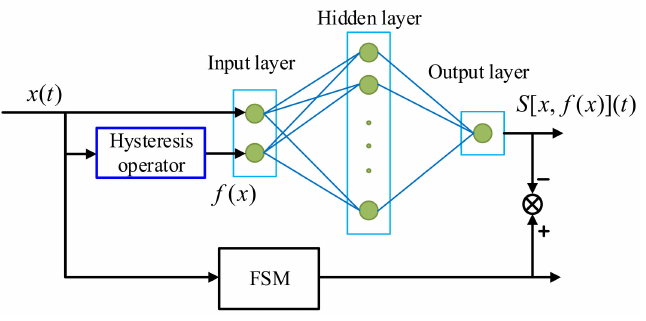
Figure 2. Architecture of the proposed hysteresis model.